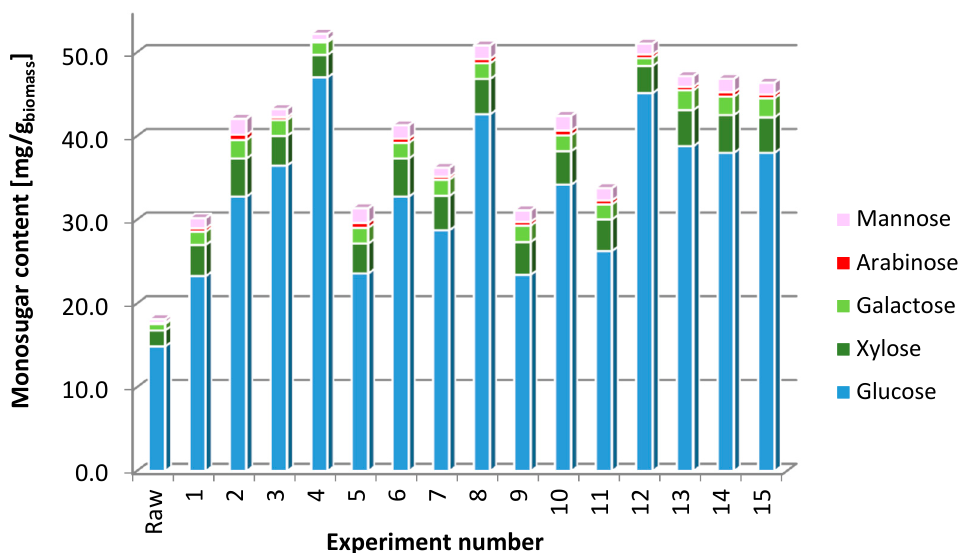
Figure 2. Content of monosugars in raw EP and alkaline pre-treated enzymatic hydrolysates corresponding to the conditions of experiments presented in Table 4.